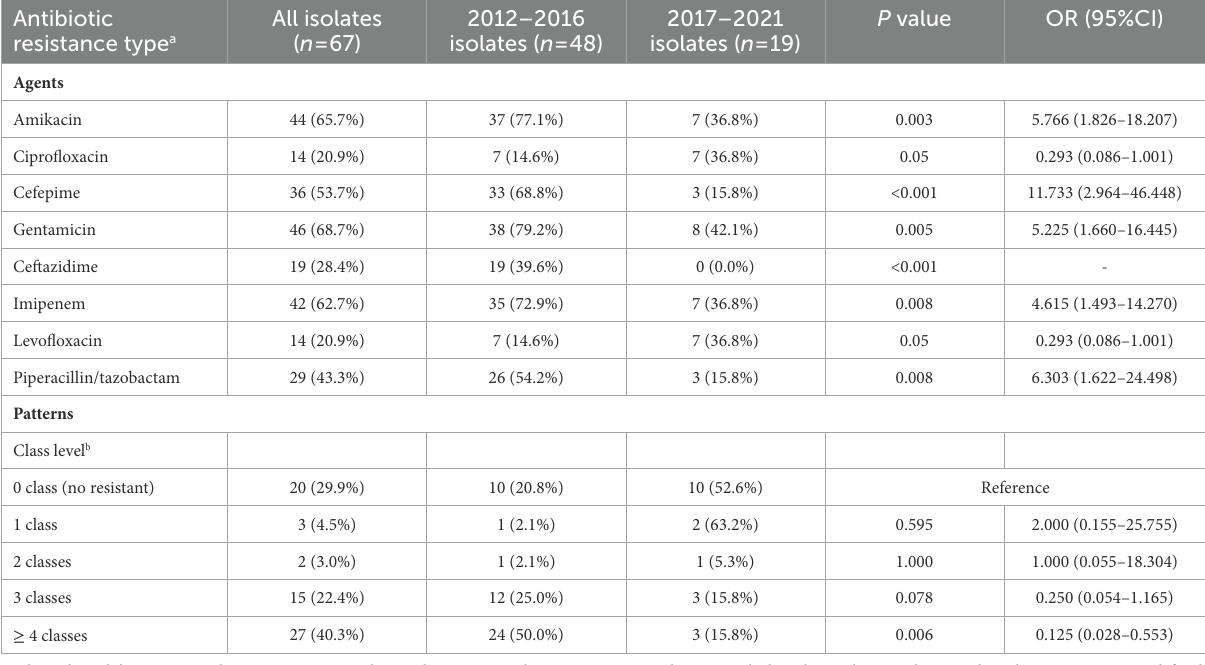
Table 4 Antibiotic resistance of Pseudomonas aeruginosa among 2012–2016 isolates and 2017–2021 isolates. Antibiotic resistance type